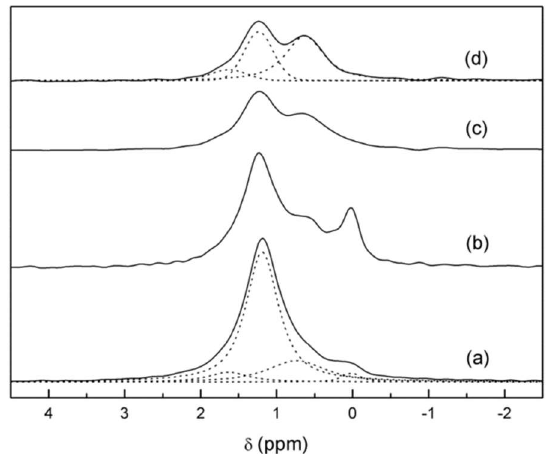
Figure 17. 6 Li MAS spectra of ( a ) enriched LLZO prepared as is ( b ) protonated LLZO before and ( c ) after washing of impurities, and ( d ) with proton decoupling. The dotted lines represent the deconvolution fit [58] .